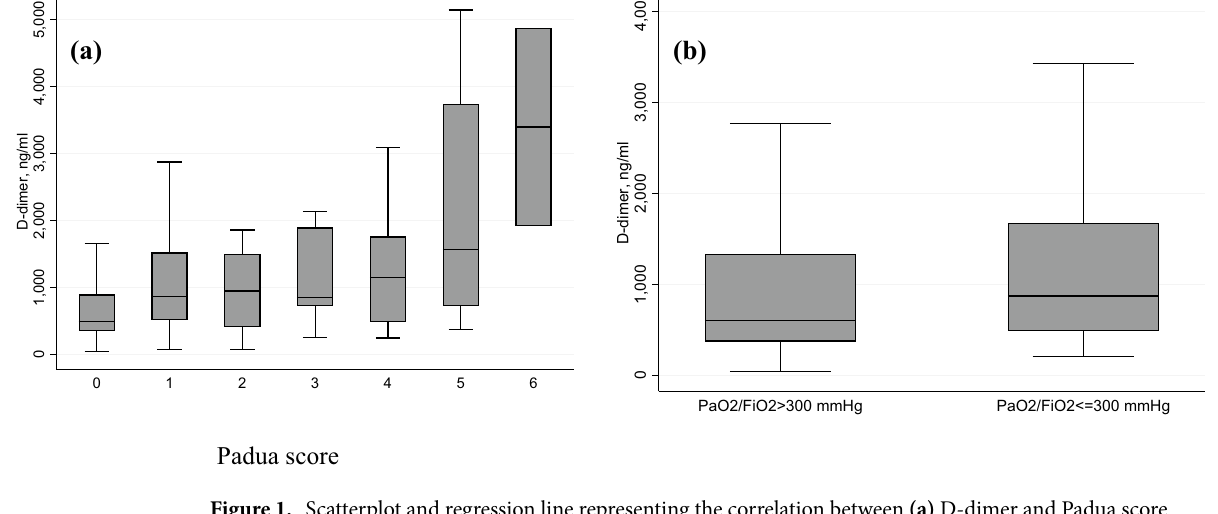
Figure 1. Scatterplot and regression line representing the correlation between (a) D-dimer and Padua score and between (b) D-dimer and PaO 2 /FiO 2 .